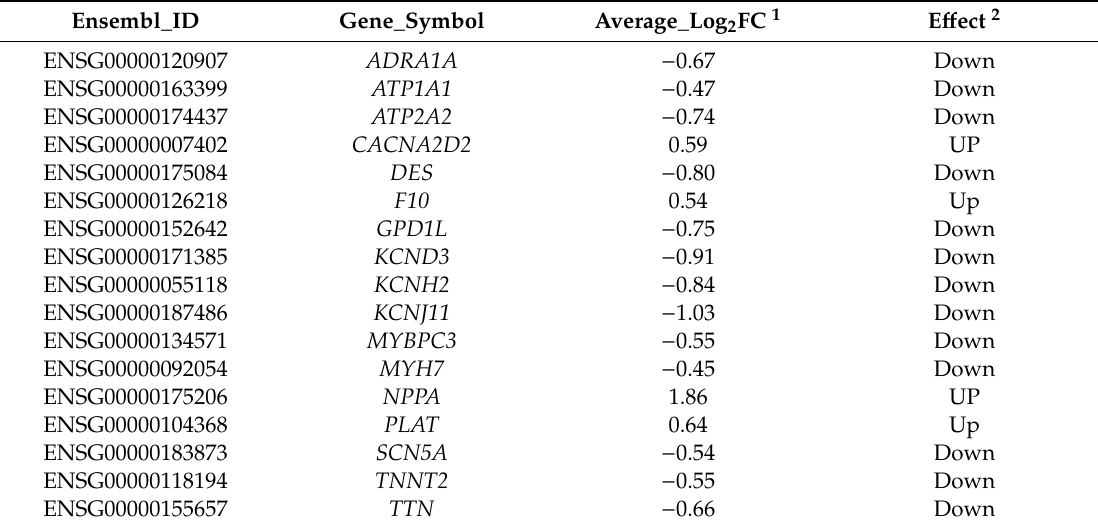
Table 4. Shared DEGs between arrhythmia and failure of heart.